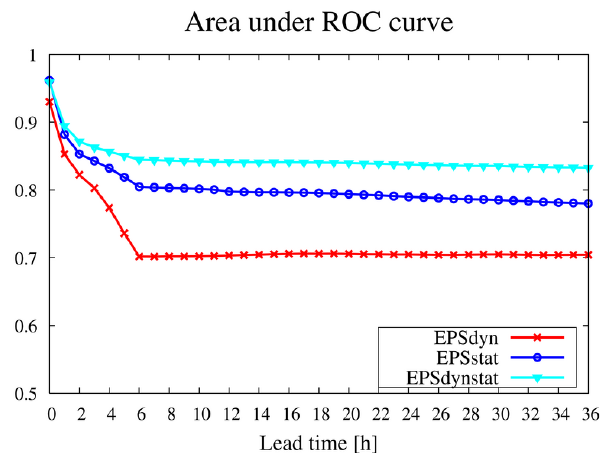
Figure 5. Area under ROC curves for 10-m wind speed > 2 m/s as a function of lead time, from the dynamical (red), statistical (dark blue) and dynamic-statistical (light blue) method.